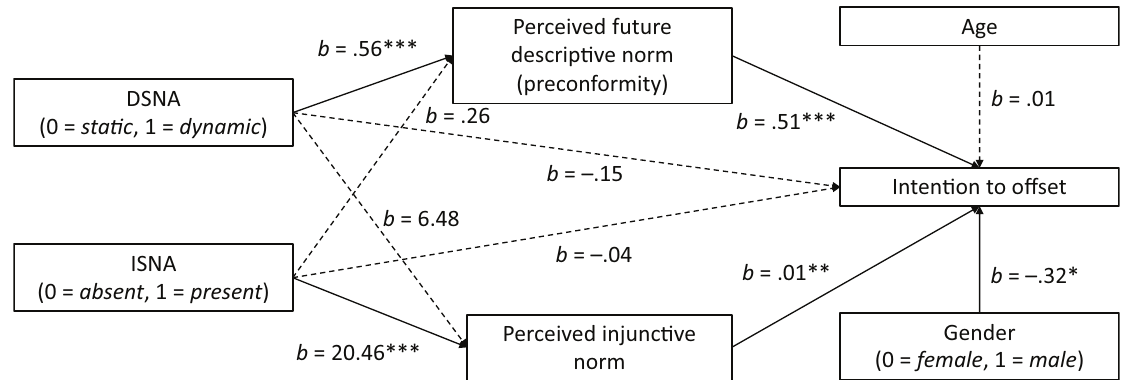
Figure 1. Mediation model. Notes: Non‐standardised regression coefficients; * p < .05, ** p < .01, *** p < .001; effects of DSNA and ISNA on the intention to offset are fully mediated by pre‐conformity ( ab = .28, 95% CI [.12, .45]) and perceived injunctive norm ( ab = .20, 95% CI [.05,